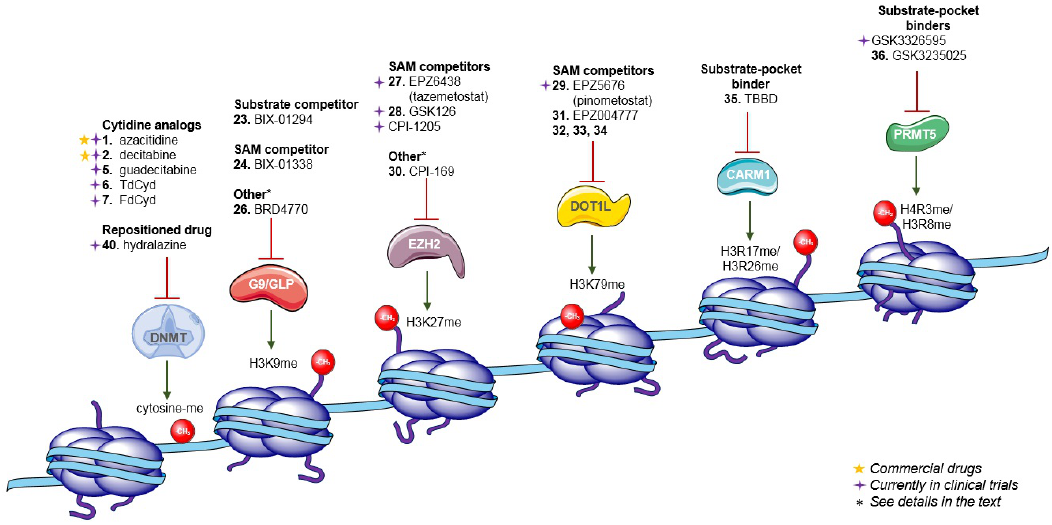
Figure 5. Summary of DNMT and HMT inhibitors. The molecules labeled with a star are commercial and those marked with a cross are currently in clinical